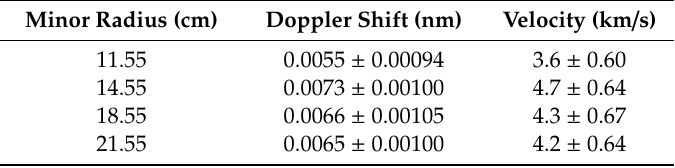
Table 2. Doppler shifts and velocities along with the error at di ff erent minor